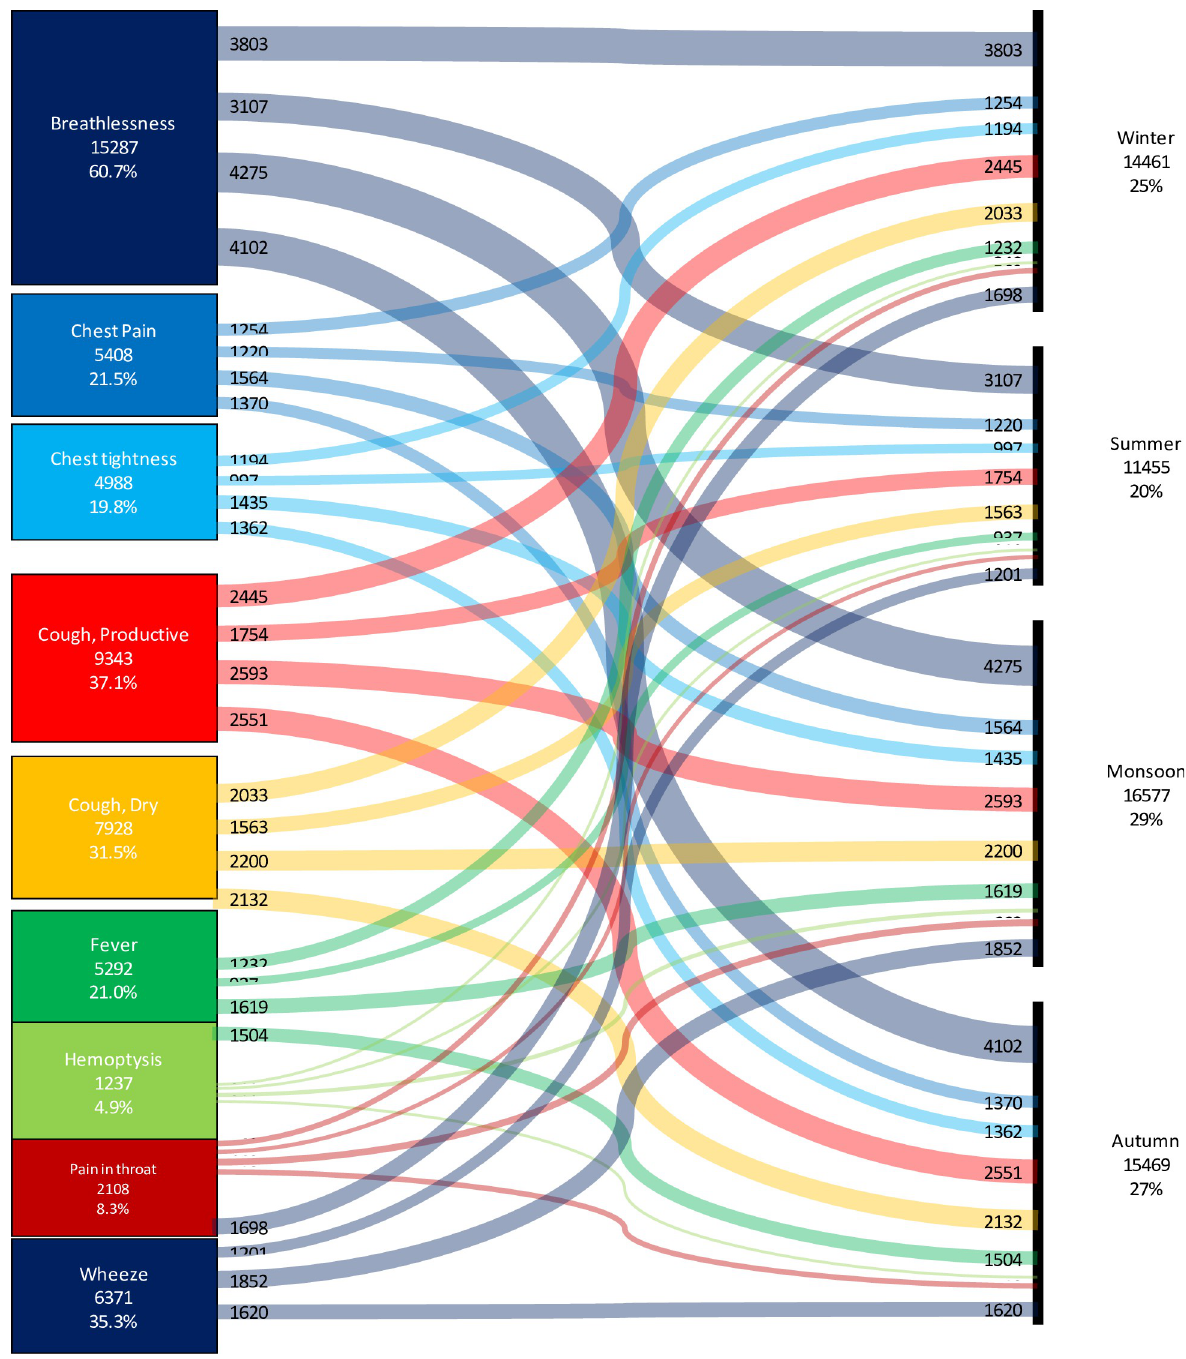
Fig 2. Sankey graph of symptoms due to respiratory disorders in the sword study across the seasons. Cough (17266,68.6%) breathlessness (15287,60.7%), and wheeze (6371,35.3%) were the most common symptoms. Symptom load was relatively less (11455,20%) during summer season.